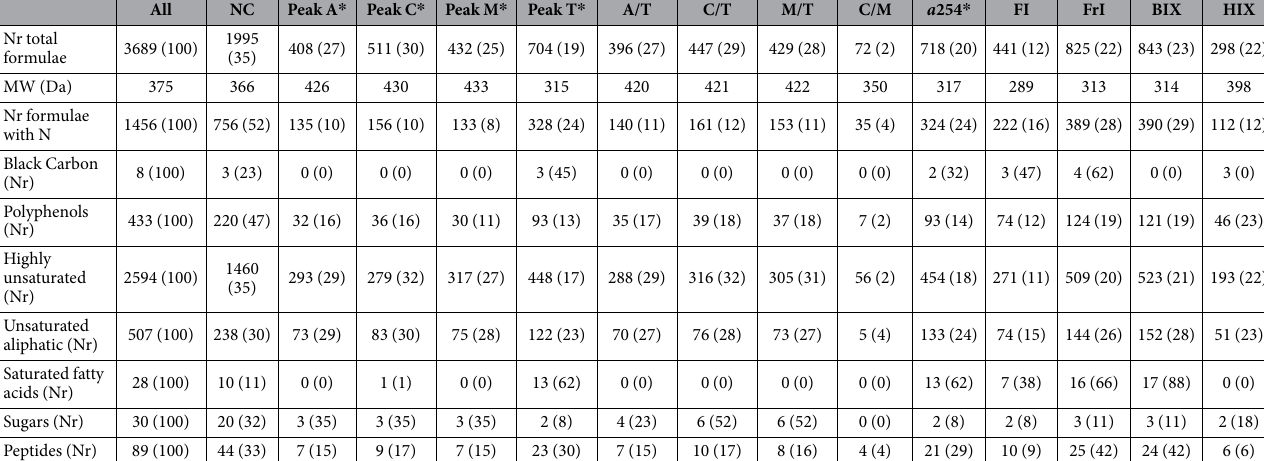
Table 1. Positive correlations between the total assigned molecular formulae as well as the different type of molecular groups and the optical parameters; carbon-specific fluorescence intensity in NFIU L mg − 1 C of general humic-like substances (peak A * ), terrestrial humic-like substances (peak C * ), marine humic-like substances (peak M * ), protein-like substances (peak T * ), fluorescence ratios (peak A/T, C/T and M/T ratios), the ratio of emission at 470 and 520 nm at excitation wavelength 370 nm, freshness index (FrI) calculated as the ratio between 380 and the maximum intensity between 420 and 435 nm at 310 emission wavelength, biological index (BIX) determined as the ratio of emission at 380 and 430 nm at 310 nm of excitation wavelength and the humification index (HIX) calculated as the ratio between the integrated emission spectra between 435 and 480 and 300–345 nm at 260 nm of excitation wavelength. NC = no correlation. MW = intensity-weighted average molecular weight, Nr = number. Numbers in parentheses correspond to the signal intensity percentage from the